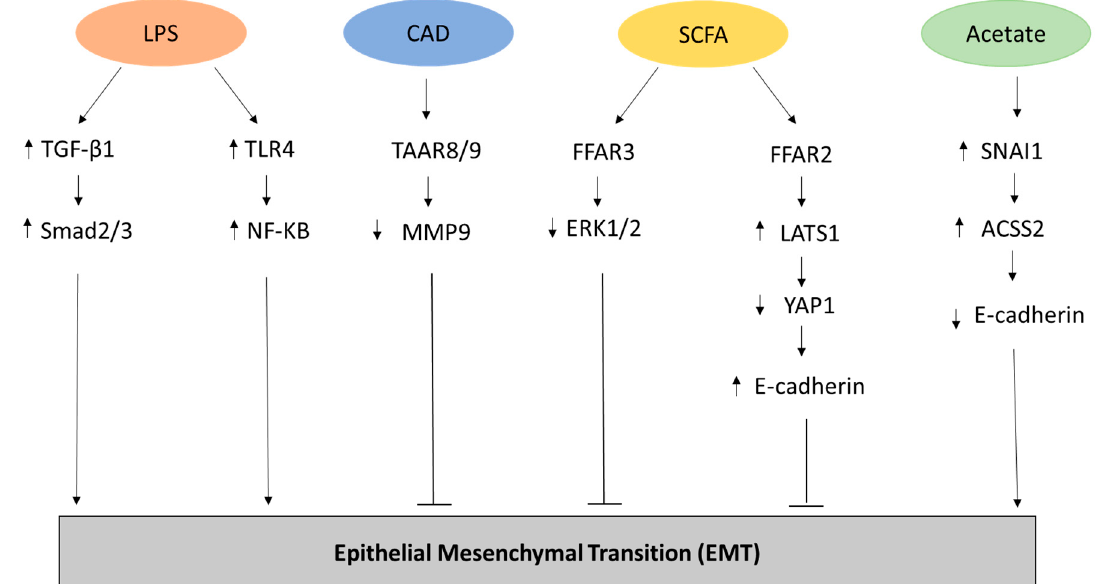
Figure 1. Representation of the metabolites and related pathways involved in the Epithelial-Mesenchymal transition (EMT) process in cancer. Lipopolysaccharide (LPS) has been shown to promote EMT through the upregulation of transforming growth factor beta-1 (TGF β -1) and Mothers Against Decapentaplegic Homolog 2 / 3 (Smad2 / 3) [22] as well through the increased expression of Toll Like Receptor 4 (TLR4) and NF-KB [23] in biliary epithelial cells. Conversely, Cadaverine (CAD) can inhibit EMT in breast cancer cell lines through the activation of trace amino acid receptors 8 and 9 (TAAR8 / 9) modulating the expression of metalloproteinase 9 (MMP9) [29]. In breast cancer cell lines, inhibition of EMT can be carried out through the metabolic pathway of short chain fatty acids (SCFAs) that activates Free Fatty Acid Receptor 2 (FFAR2), leading to inhibition of the Hippo-Yap pathway and increased expression of adhesion protein E-cadherin, and FFAR3, resulting in mitogen-activated protein kinase (MAPK) signaling inhibition [30]. Finally, acetate can promote EMT by increasing the expression of the zinc finger protein Snail Family Transcriptional Repressor 1 (SNAI1) and Acyl-CoA Synthetase Short Chain Family Member 2 (ACSS2) in renal carcinoma cells under glucose limitation